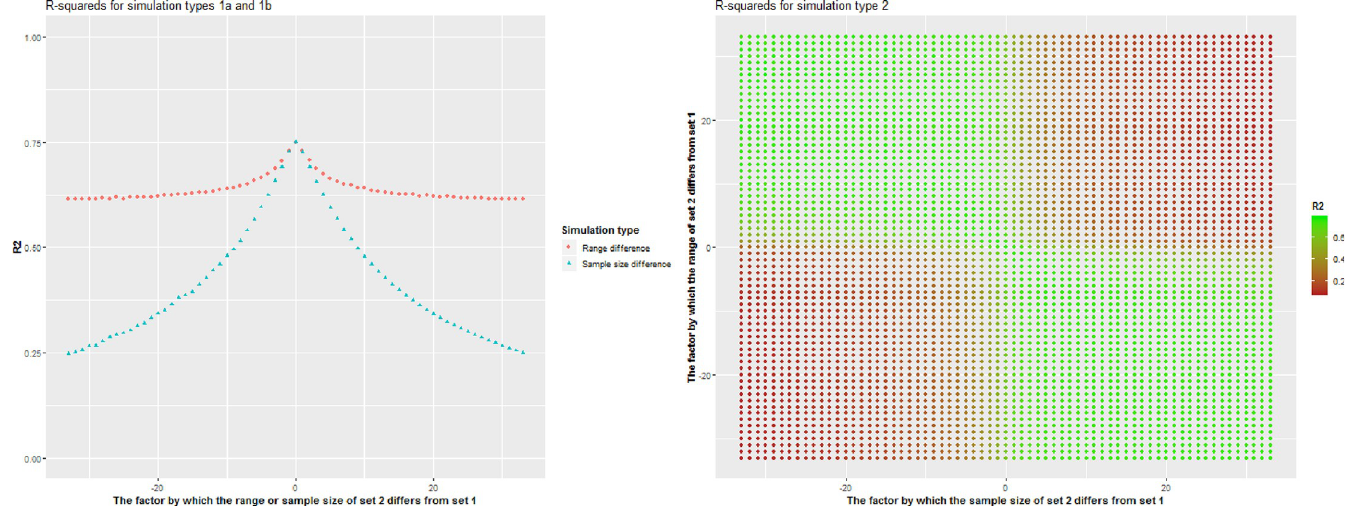
Fig 3. R2s for simulations in which numbers between 0 and 1000 are recoded to 0 and those above 1000 to 1. For all iterations, 1000 numbers between 0 and 1000 were sampled and recoded to 0. Numbers that were recoded to 1 originated from sampling numbers between 1001 and N with sample size K. Left: K was a constant of 1000, N was between 1 and 34 times as high or low as 1000 (simulation type 1a, red circles); N was a constant of 2001, K was between 1 and 34 times as high or low as 1000 (simulation type 1b, blue triangles). Right: N was between 1 and 34 times as high or low as 1000 and K was between 1 and 34 times as high or low as 1000 (simulation type